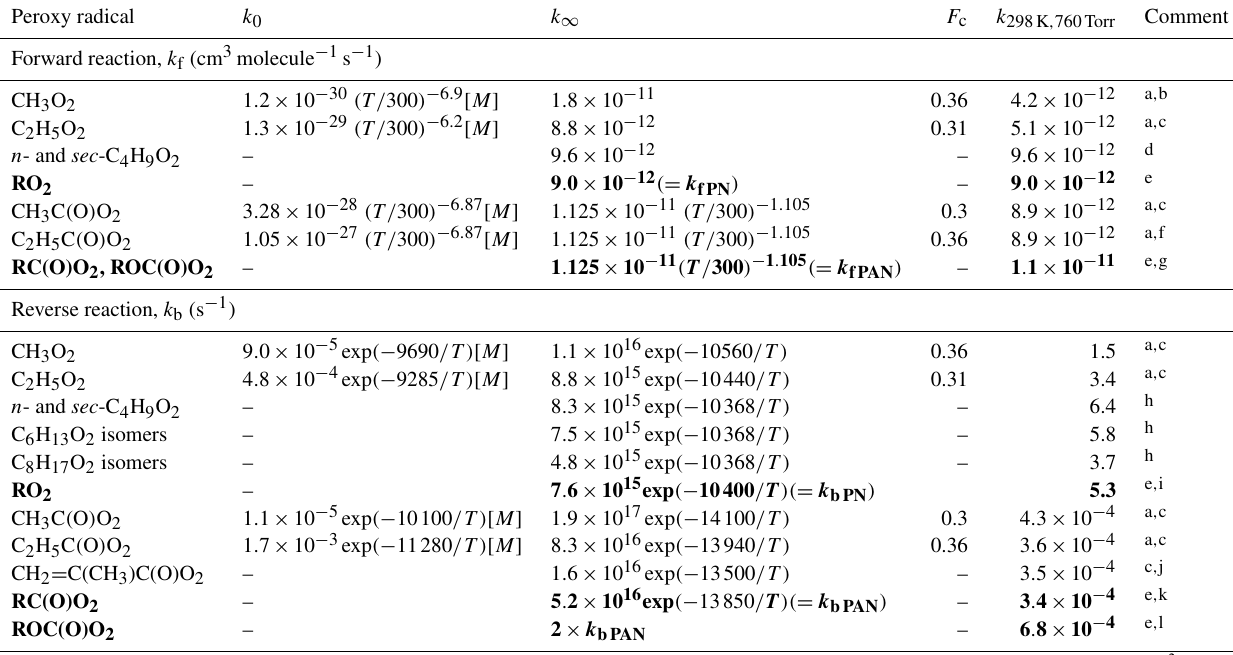
Table 4. Rate coefficients for the reactions of hydrocarbon and oxygenated RO 2 radicals with NO 2 and for the reverse decomposition of the RO 2 NO 2 products. Generic rate coefficients for specified RO 2 classes are shown in bold font. Peroxy radical k 0 k ∞ F c k 298K , 760Torr